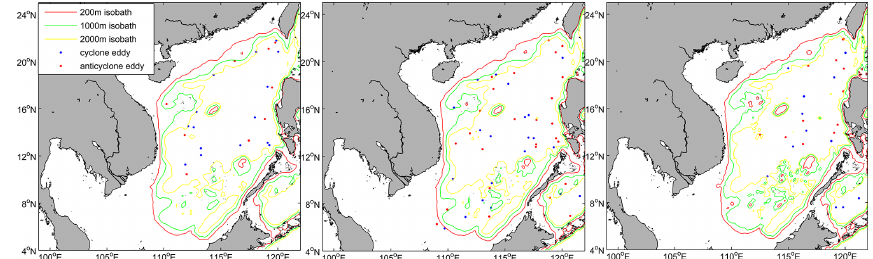
Figure 12. The spatial distributions of eddies’ origins, identified using the method of Chaigneau et al. (2008) in the SCS from AVISO (left), Mercator Océan (middle), and SCSOFS (right) in